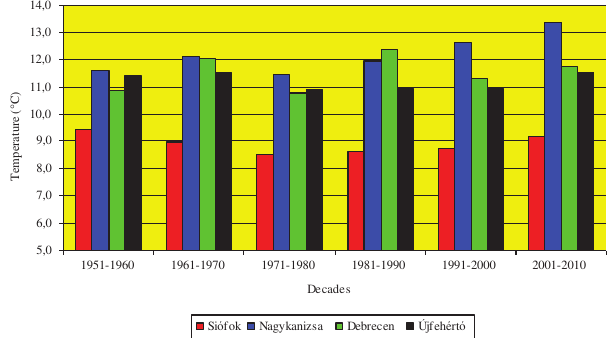
Figure 5 – The mean daily variation of 10 year long periods during the blooming season (April 1 – May 15) in four fruit growing regions over 60 years: 1951–2010